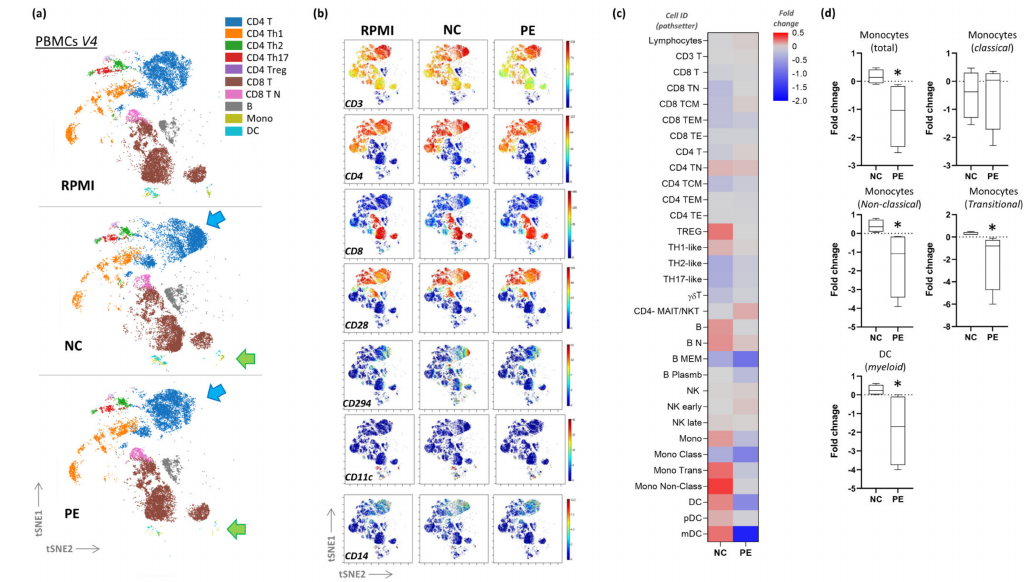
Figure 5. Phenotyping of treated PBMCs with NC/PE fermentation supernatants (FSs) with mass cytometry. ( a ) viSNE maps presenting the similarities of identified cell types (cell definitions are based on automatic gating performed in Cytobank—each dot represents a single cell) in PBMCs of V4 after different treatments (RPMI, NC, and PE) and ( b ) viSNE maps presenting the expression of markers CD3, CD4, CD8, CD294, CD28, CD11c, and CD14 on this analysis. ( c ) Heatmap showing fold changes in abundance of different cell types identified with the Pathsetter analysis in treated PBMCs from all volunteers and ( d ) boxplots for monocytes and myeloid DCs. RPMI: baseline, absence of treatment; NC: treatment with FSs from fermentation in the absence of additional carbon source; PE: treatment with FSs from fermentation in the presence of lyophilized mushroom powder of P. eryngii . Asterisks indicate statistical significance as shown by Mann–Whitney test, with * p <